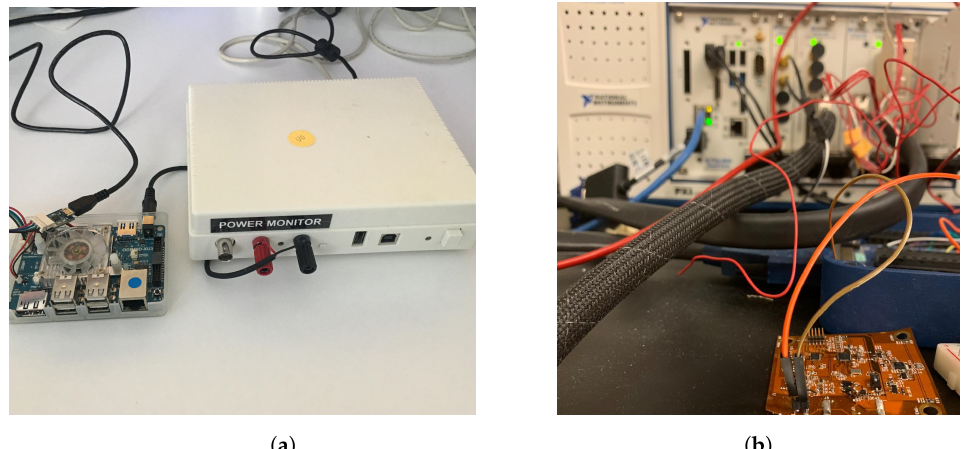
Figure 8. ( a ) Wi-Fi experiment setup with Power monitoring tool. The Odroid board is connected to a low voltage power monitor tool from Monsoon Solution; ( b ) flexible prototype experiment setup with NI-DAQ